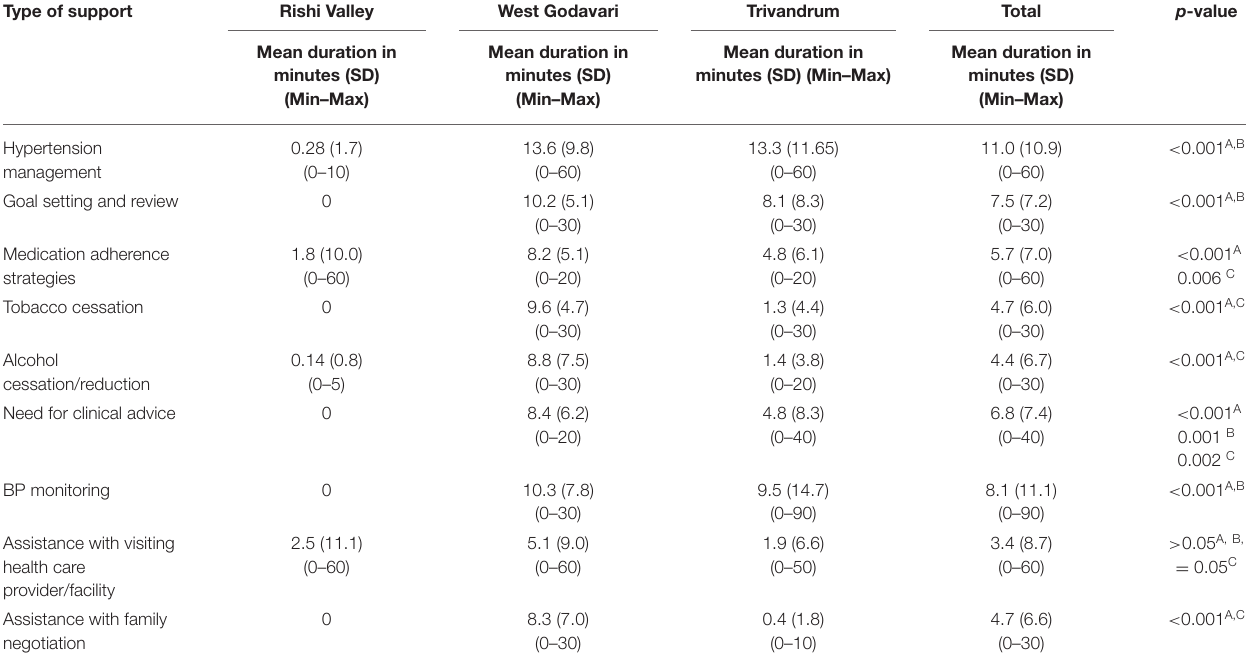
TABLE 3 | Mean duration (minutes) of between-meeting support given by ASHAs to participants.